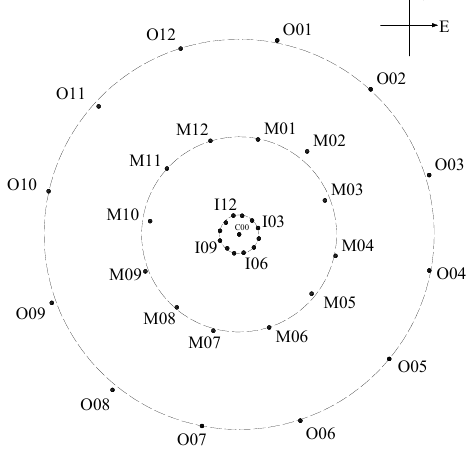
Figure 6. The SMART-1 array.